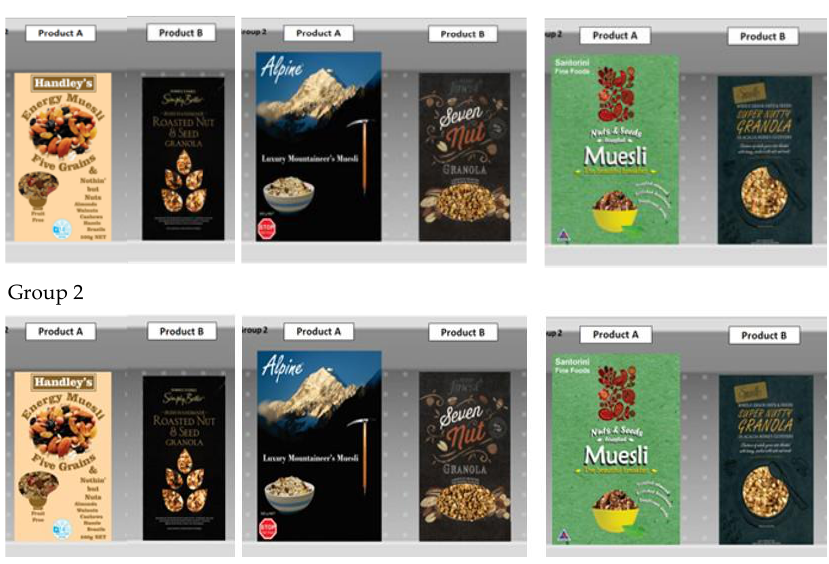
Figure 6. Experimental design details showing the product diads used to present the FoP labels to Groups